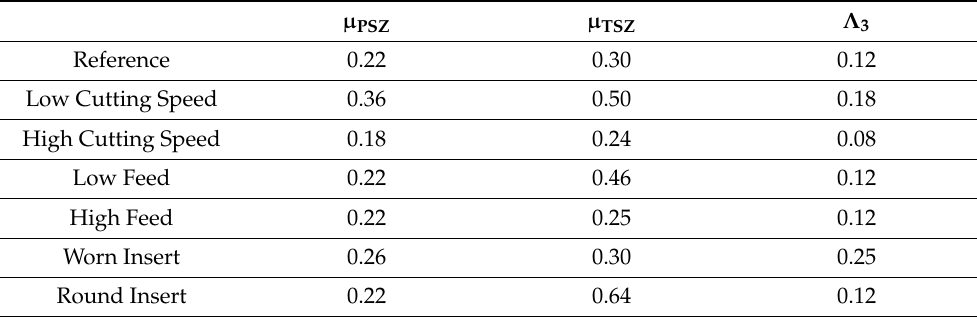
Table 6. Friction and heat partition coefficients extracted from the tribological